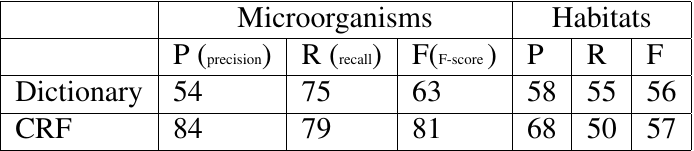
Table 2: Performance of CRF and dictionary-based